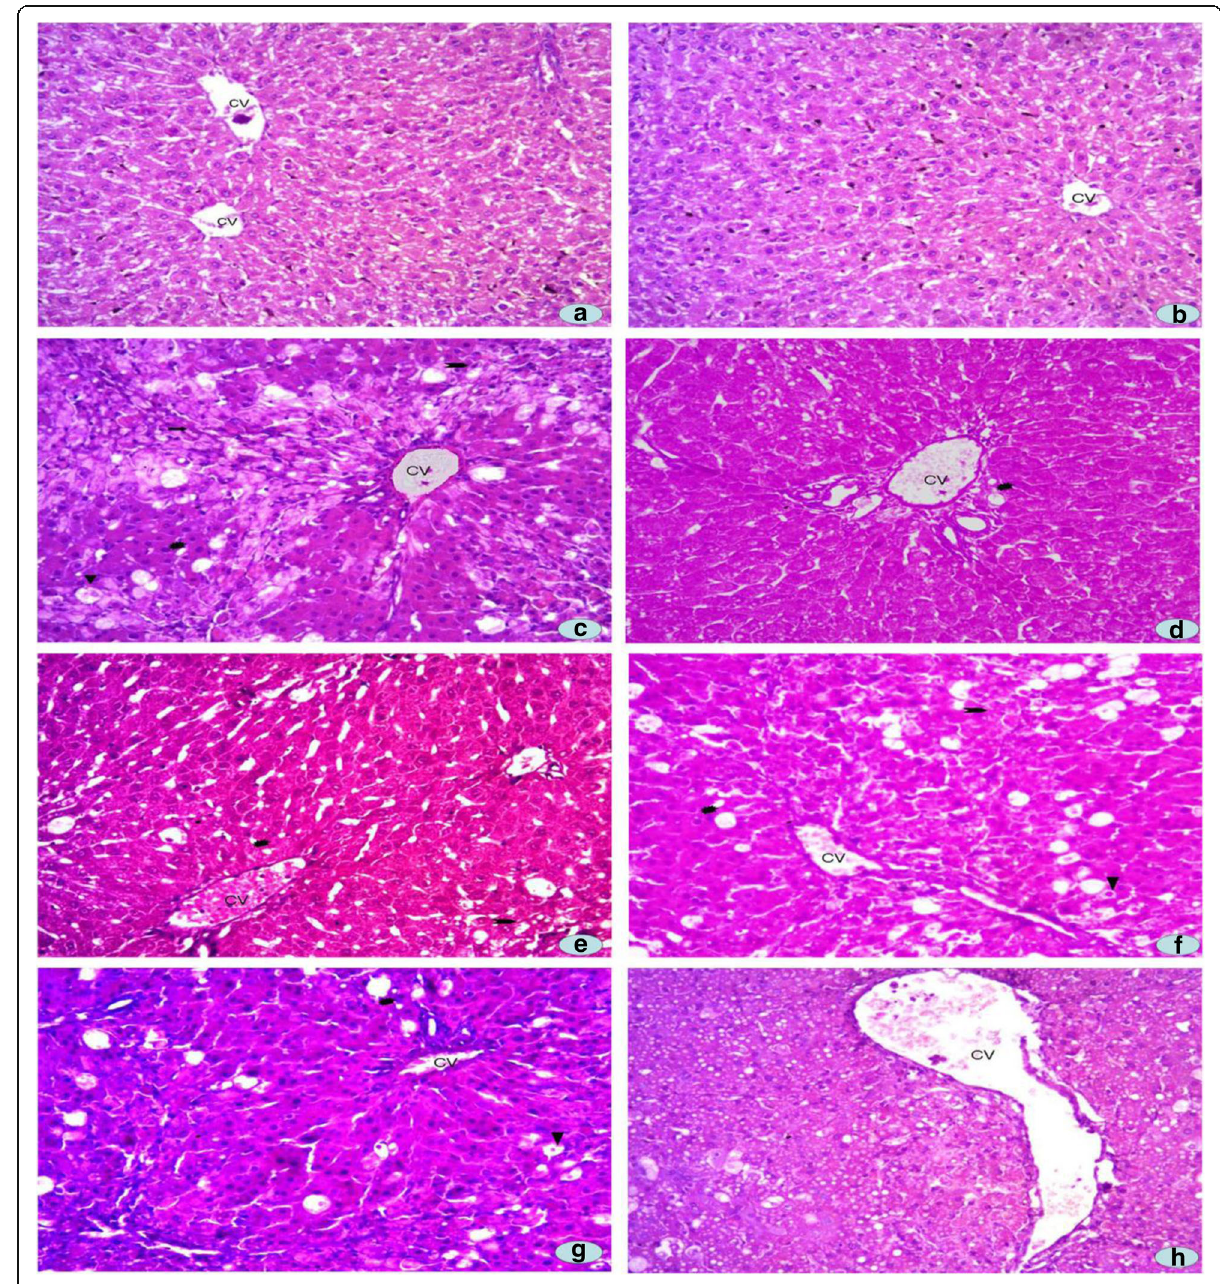
Fig. 2 Microphotograph of rat liver (H & E stain) ( → ) fibrosis, ( ♦ ) cellular hypertrophy, ( ▲ ) fatty changes and ballooning: ( a ) Representative section of liver from the control group showing normal histology, ( b ) DMSO + Olive oil group, ( c ) CCl4 group, ( d ) Silymarin + CCl4 group, ( e ) ELR + CCl4 group, ( f ) MLR + CCl4 group, ( g ) ELR group, ( h ) MLR